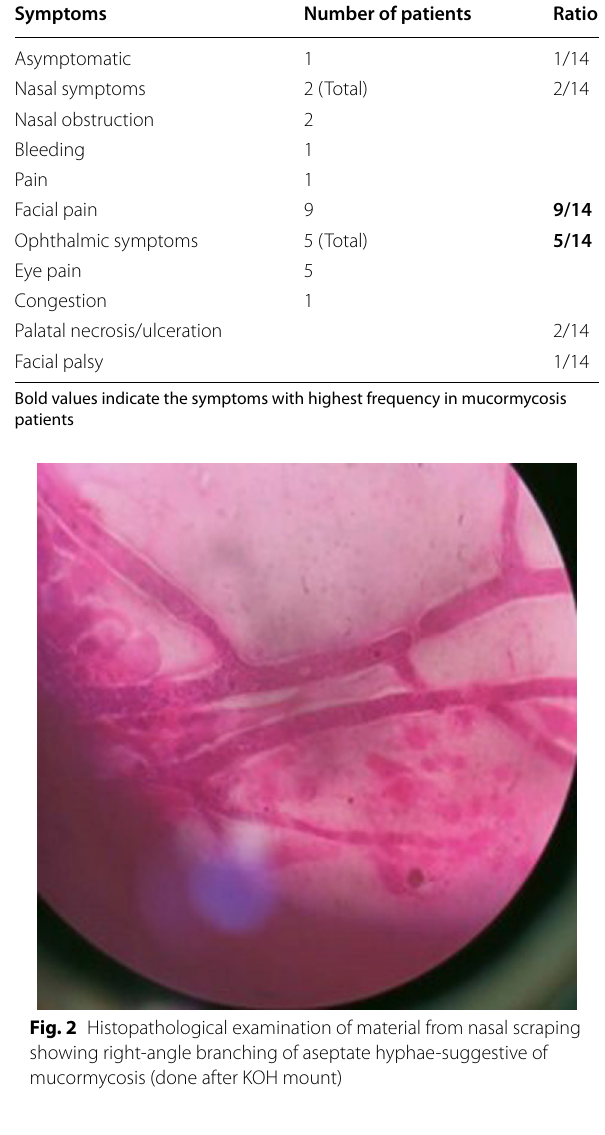
Table 4 Classification of COVID-19-associated rhino-orbital- cerebral mucormycosis (ROCM) as possible, probable and proven